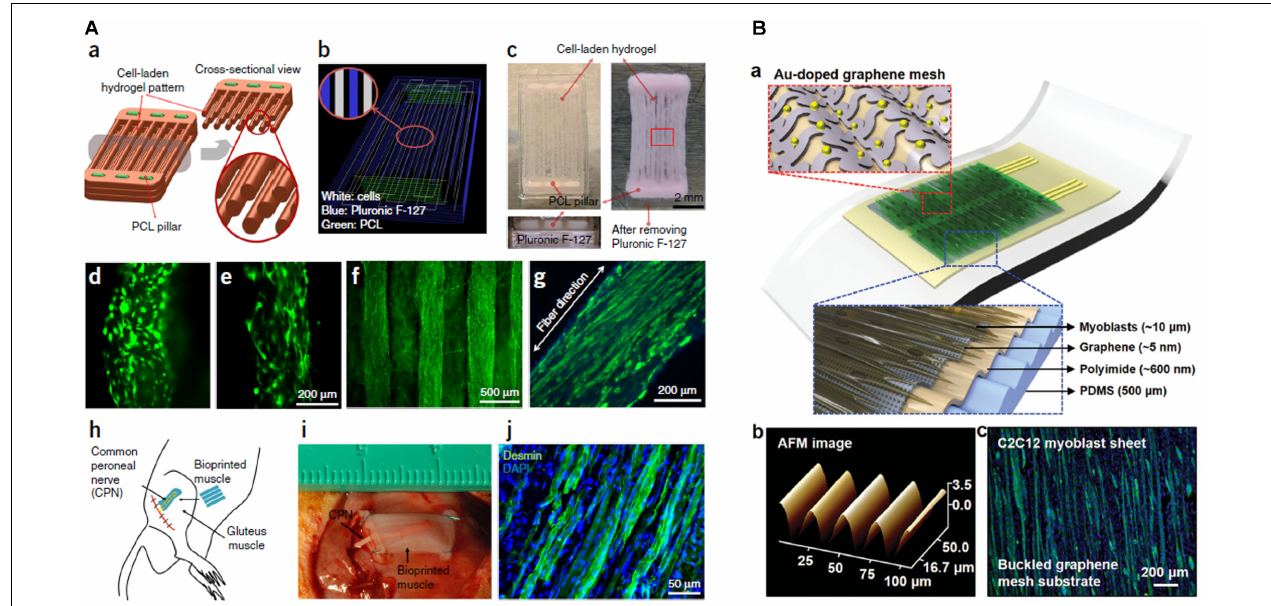
FIGURE 2 | (A) Bioprinted muscle. (a) Fiber bundle structure for muscle organization with PCL pillars (green) used to maintain the structure and to induce cell alignment. (b) Visualized motion program for 3D printing muscle construct. Lines of green, white and blue indicate the dispensing paths of PCL, cell-laden hydrogel and sacrificial material, respectively. (c) 3D patterning outcome of designed muscle organization before and after removing the sacrificial material. The PCL pillar structure is essential to stabilize the 3D printed muscle as visible from scaffolds without PCL pillar (d) and with PCL pillar (e) . The cells with PCL pillar showed unidirectionally organized cellular morphologies (f) . The live/dead staining of the encapsulated cells in the fiber structure indicates high cell viability (green: live; red: dead). (g) Immunofluorescent staining for myosin heavy chain of the 3D printed muscle organization after 7 days differentiation. (h) Schematic diagram of ectopic implantation of bioprinted muscle construct in vivo . (i,j) The bioprinted muscle construct subcutaneously implanted and the harvested implants after 2 weeks of implantation showed the presence of organized muscle fibers and innervating capability within the implanted construct, as confirmed by desmin muscle marker (j) . Reproduced with permission from Kang et al. (2016). Copyright 2016 Nature America. (B) The architecture of the stretchable and transparent cell-sheet–graphene hybrid made of layers of C2C12 myoblasts, an ultrathin graphene mesh doped with Au, Au nanomembrane connective electrodes, polyimide and a PDMS substrate (a) . Atomic force microscope image of graphene mesh (b) and C2C12 myoblasts (c) labeled for myosin heavy chain (green) and nuclei (blue). Reproduced with permission from Kim et al. (2016), Copyright Elsevier Ltd.,